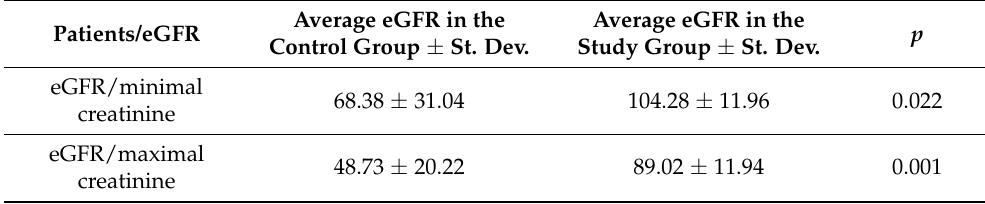
Table 5. Variability of the average eGFRs (mL/min/1.73 sqm) between groups. Average eGFR in the Patients/eGFR Control Group ± St.